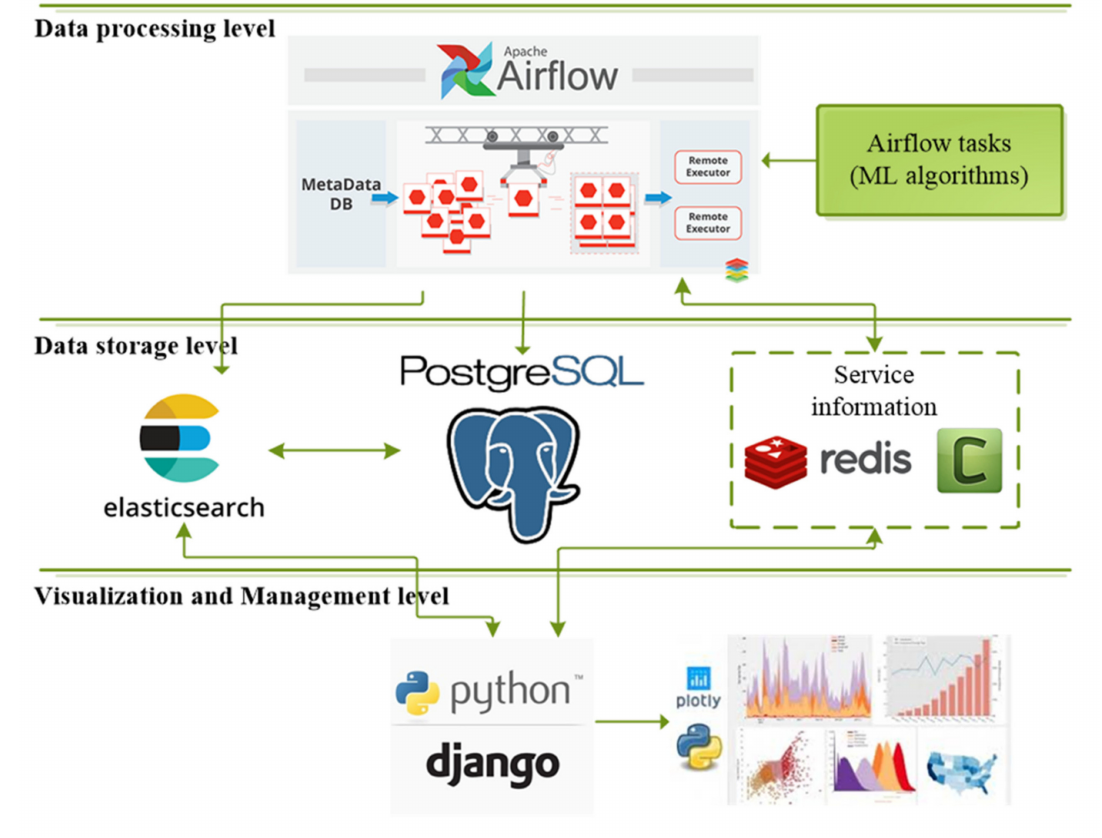
Figure 7. Multilayer system